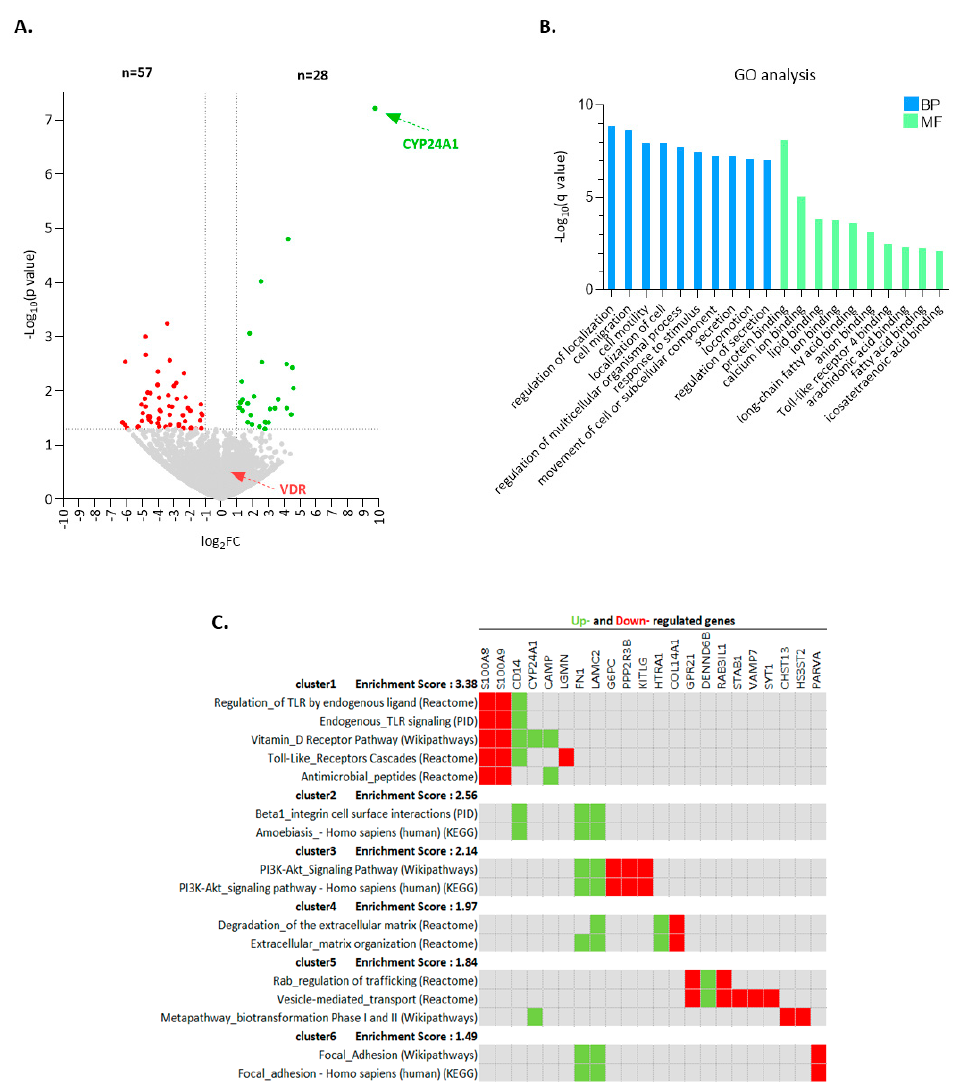
Figure 2. Calcitriol-treated CLL cells display a distinct transcriptional profile. ( A ) Volcano plot indicating the differentially expressed genes in calcitriol-treated vs untreated CLL cells. The fold change of gene expression is displayed on the x-axis and the significance of difference in gene expression [( − log10( p value)] is shown on the y-axis. The significantly upregulated genes are highlighted in green, whereas, the significantly downregulated genes are highlighted in red. ( B ) GO enrichment analysis showing top 10 significantly enriched biological processes (BP) and molecular functions (MF) in calcitriol-treated CLL cells. ( C ) The figure presents enriched pathways from the pathway enrichment analysis ( q value < 0.1) and the differentially expressed genes between calcitriol-treated and non-treated CLL cases that are implicated. Upregulated genes are illustrated in green, whereas downregulated genes are shown in red. Enrichment score for each cluster is considered the overall enrichment score for the group based on the p value of each term members.